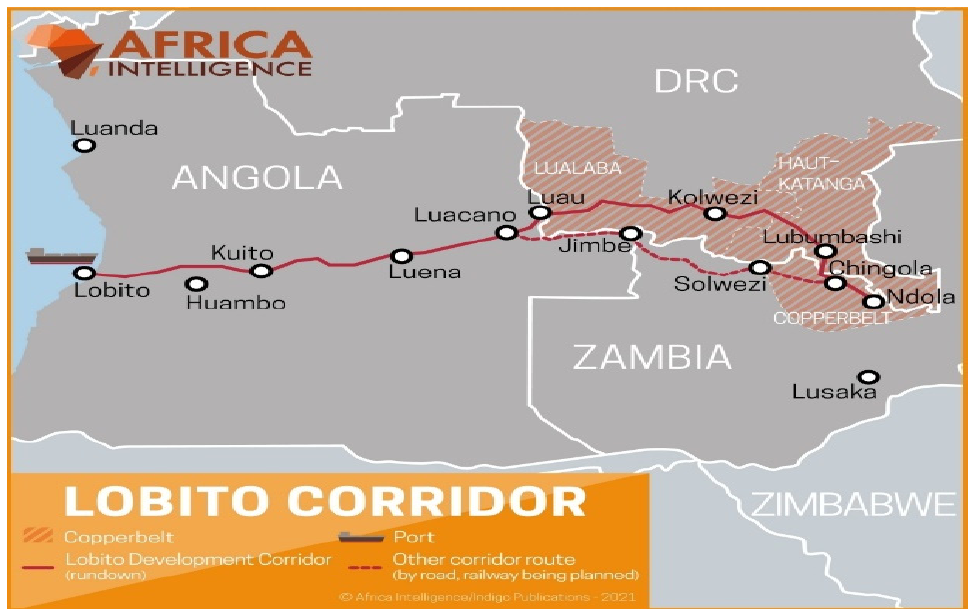
Figure 1. The Lobito Corridor. Source: Instituto Cartográfico de Angola 2020).